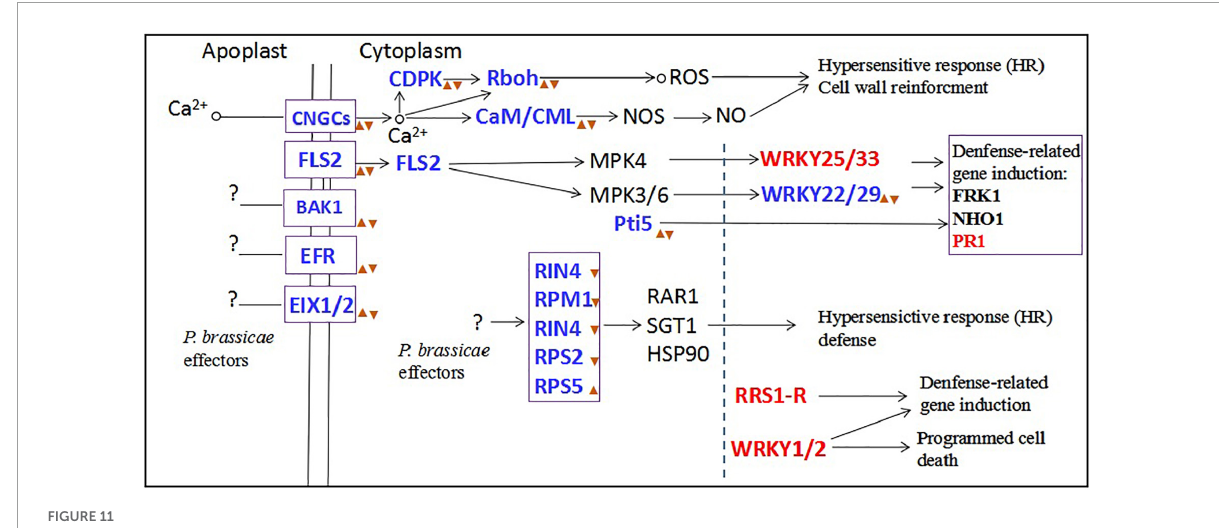
FIGURE11 The plant-pathogen interaction pathway after primary zoospores or secondary zoospores infection. Red font represents the genes of upregulation expression by both primary and secondary zoospore infection compared with control. Blue fonts represent the genes of upregulation expression by primary zoospores infection compared with secondary zoospores. (cid:78) represent the genes of upregulation expression by primary zoospores infection compared with control. (cid:72) represent the genes of downregulation expression by secondary zoospores infection compared with